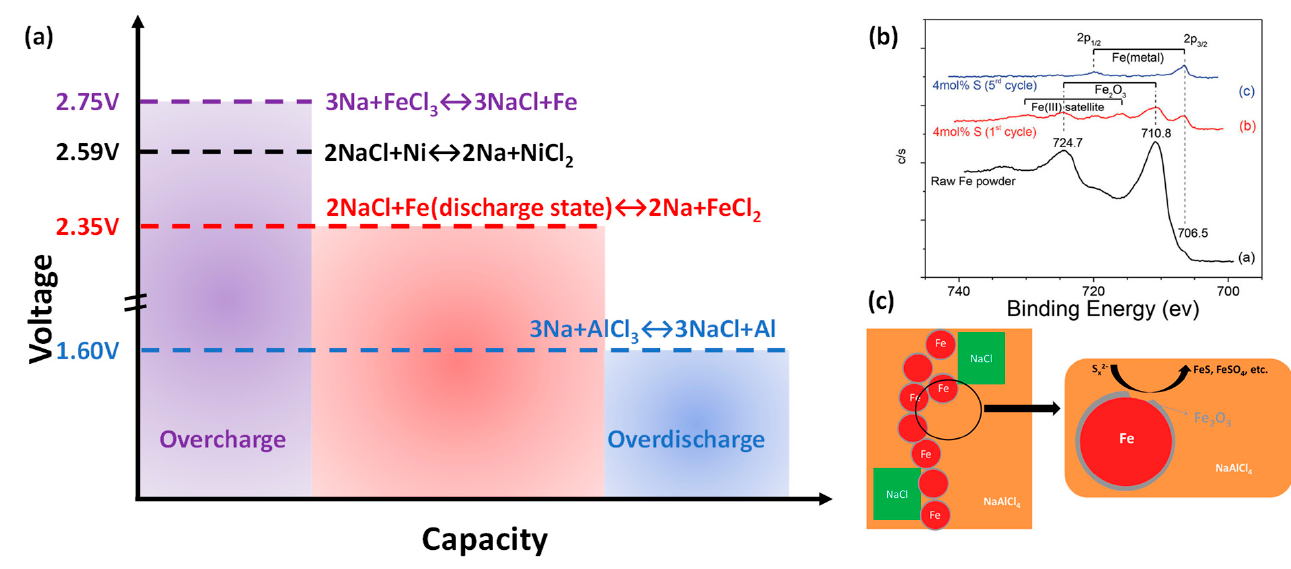
Figure 7. ( a ) Cell reactions in Na-MH battery using an iron chloride cathode. ( b ) XPS Fe2p spectra for raw Fe powder and cycled Fe cathodes (4 mol% S). ( c ) Proposed reaction path for removing oxide layers on Fe particles via polysulfide reaction ( b – c , adapted with the permission from Wiley).